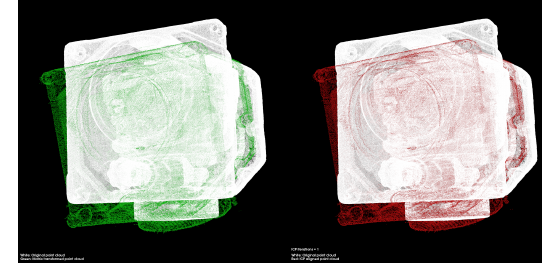
Figure 10. FPFH-based coarse registration